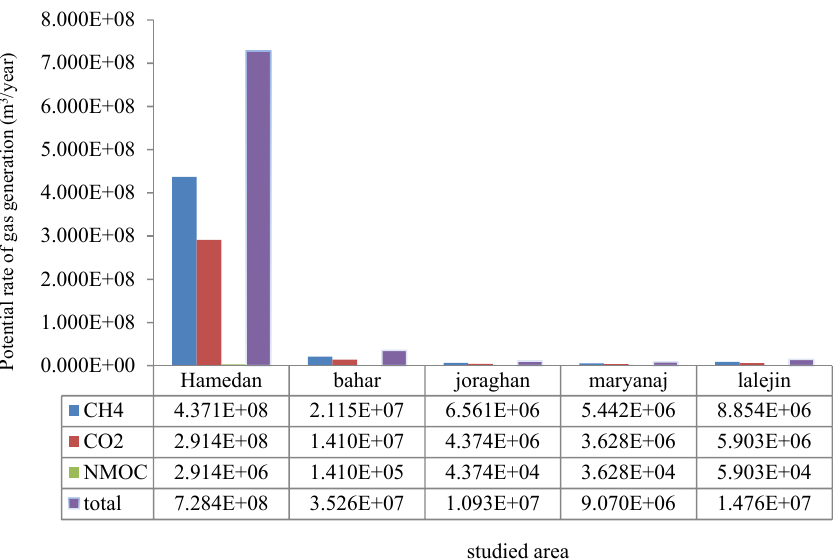
Fig. 3: Potential rate of gas generation (methane, carbon dioxide, non-methane organic carbon (NMOC) and total gases) during 2011 to 2030 in the study area